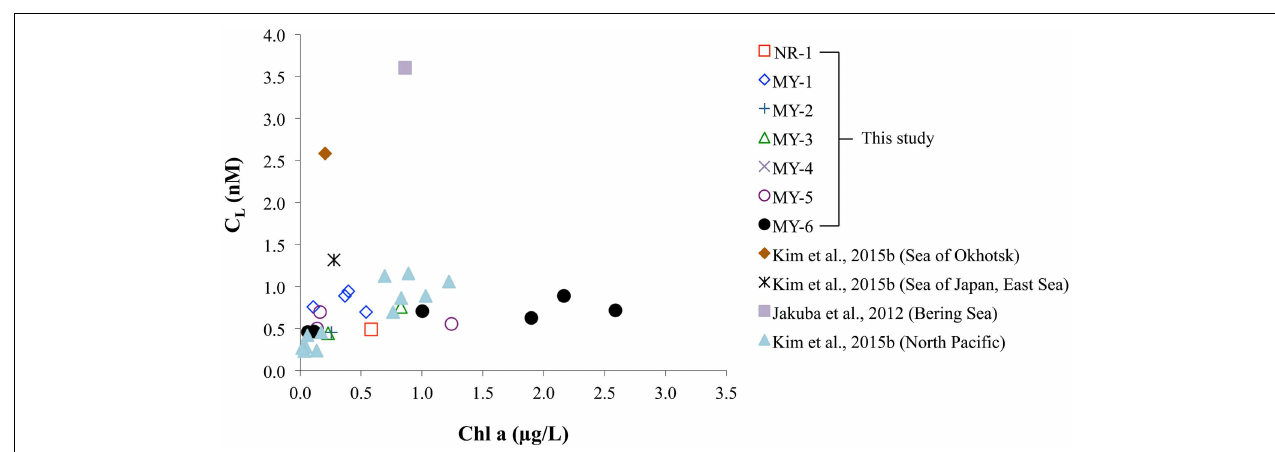
FIGURE 8 | Comparison of Chl a and C L obtained in this study and data from previous studies in the Sea of Okhotsk, Sea of Japan (East Sea), North Pacific (Kim et al., 2015b), and Bering Sea (Jakuba et al., 2012), respectively.